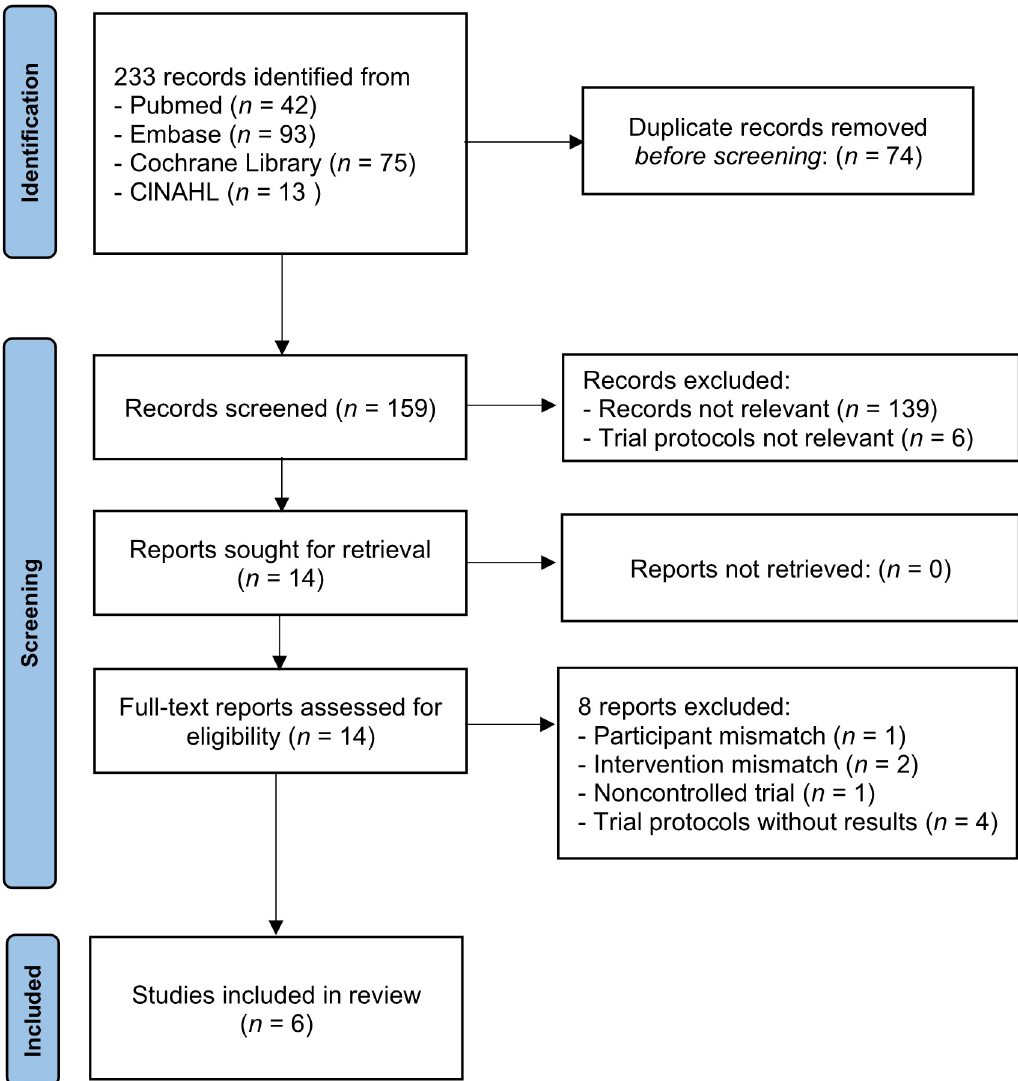
Fig 1. PRISMA diagram showing the process of trial selection. The systematic review and meta-analysis searched four databases, removed the duplicated records, and screened the titles and abstracts of records. After examining 14 full-text reports of relevant records, six trials were quantitatively